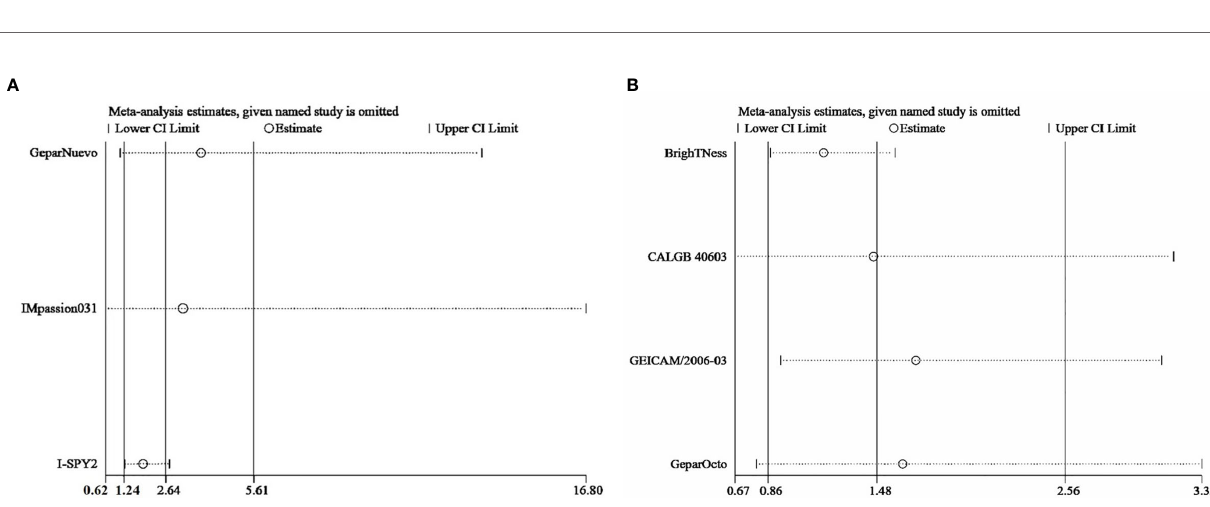
FIGURE 4 | Forest plot showing pooled OR of pCR in patients receiving ICIs vs AT-based NACT and platinum-based vs AT-based NACT in early TNBC patients.